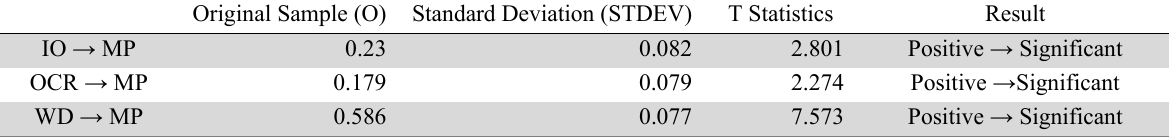
Results of Hypothesis Original Sample (O) Standard Deviation (STDEV) T Statistics Result IO → MP 0.23 0.082 2.801 Positive → Significant OCR → MP 0.179 0.079 2.274 Positive → Significant 0.586 0.077 7.573 Positive →